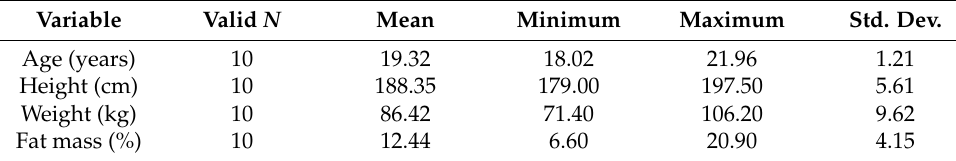
Table 1. Basic descriptive statistics of the respondents ( n =